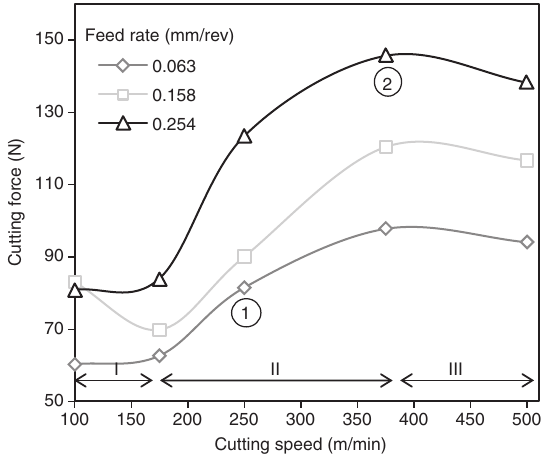
Figure 7: Effects of feed rate and cutting speed on the cutting force, 0 ° lead